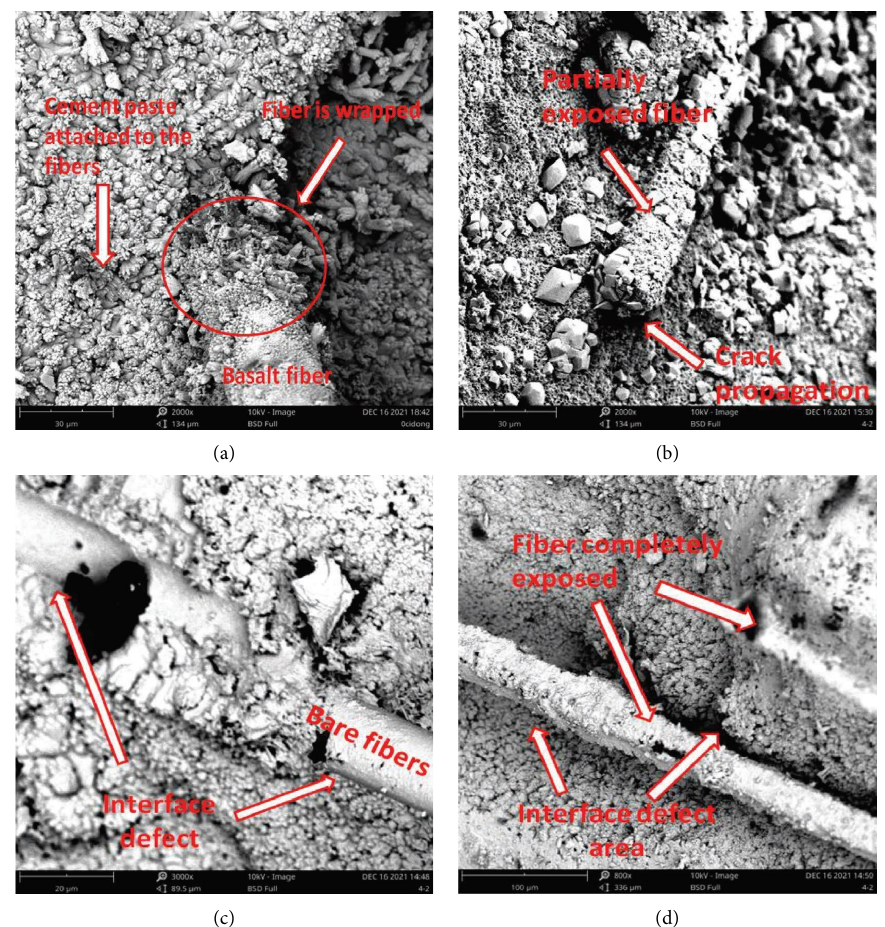
Figure 12: Microstructure of fber-cement-based interface with diferent diameters. (a) Microstructure of 14 μ m fber-cement base interface. (b) Microstructure of 15 μ m fber-cement base interface. (c) Microstructure of 17 μ m fber-cement base interface. (d) Microstructure of 20 μ m fber-cement base interface.